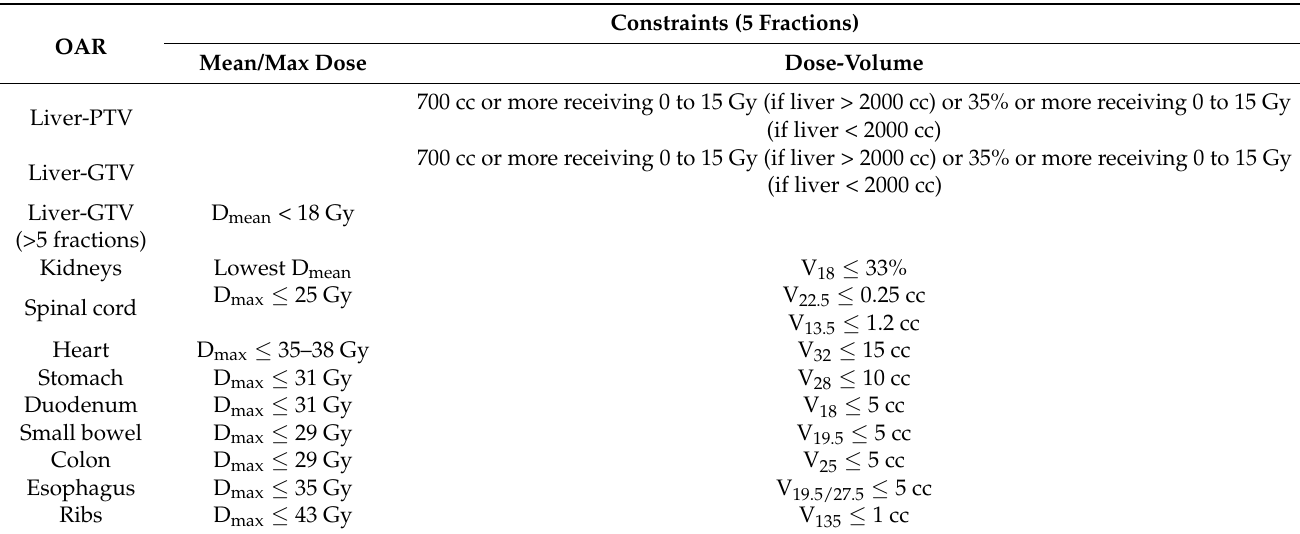
Table 1. Dose constraints at OARs